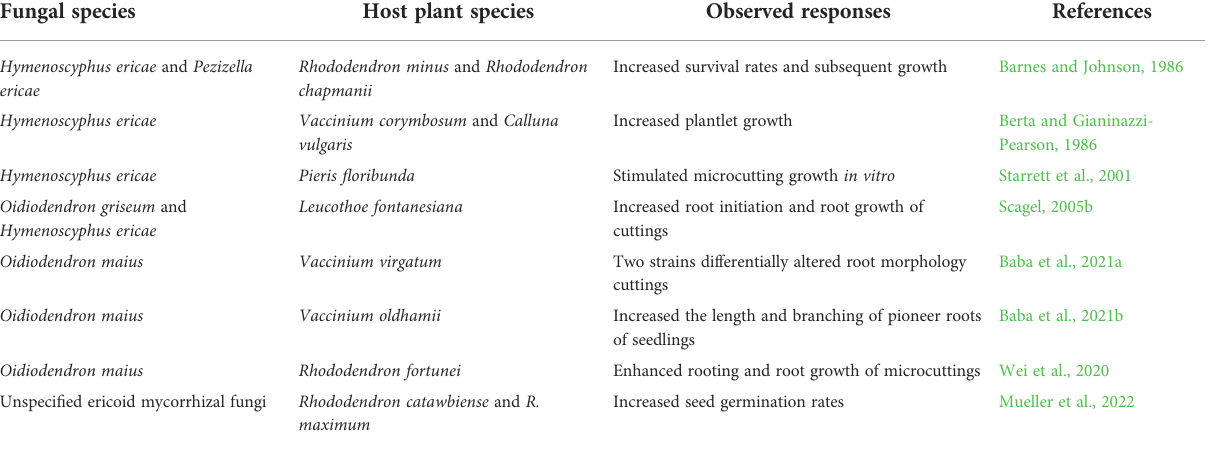
TABLE 1 Ericoid mycorrhizal fungi improve seed germination and rooting of cuttings. Fungal species Host plant